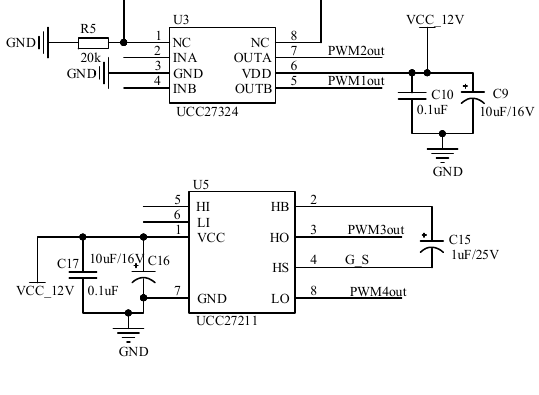
Figure 8. MOSFET drive circuit.